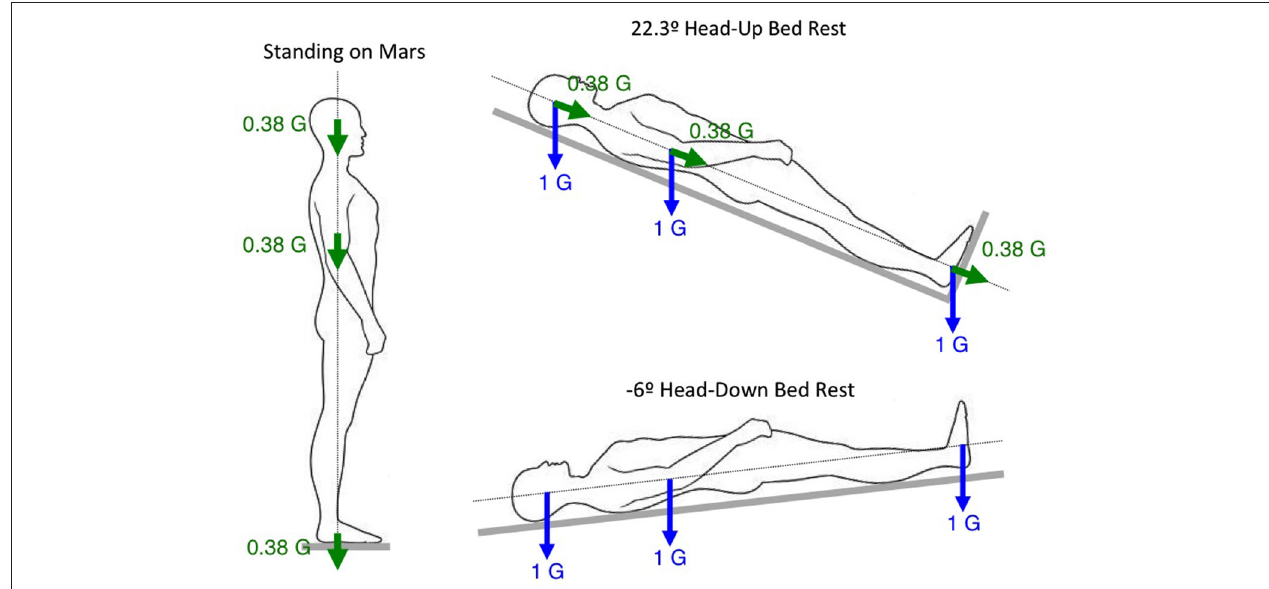
FIGURE 5 | Rationale for evaluating the effects of Martian gravity during head-up tilt .